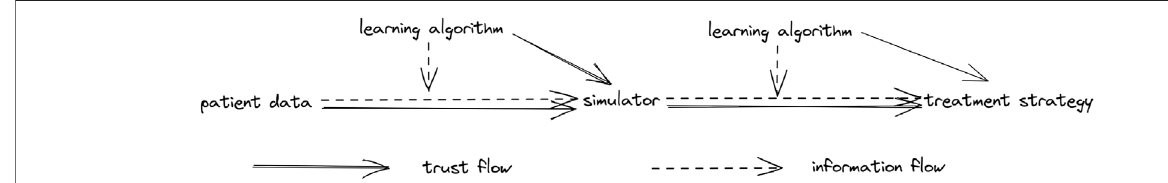
FIGURE 1 | Trust graph of simulator as a model.